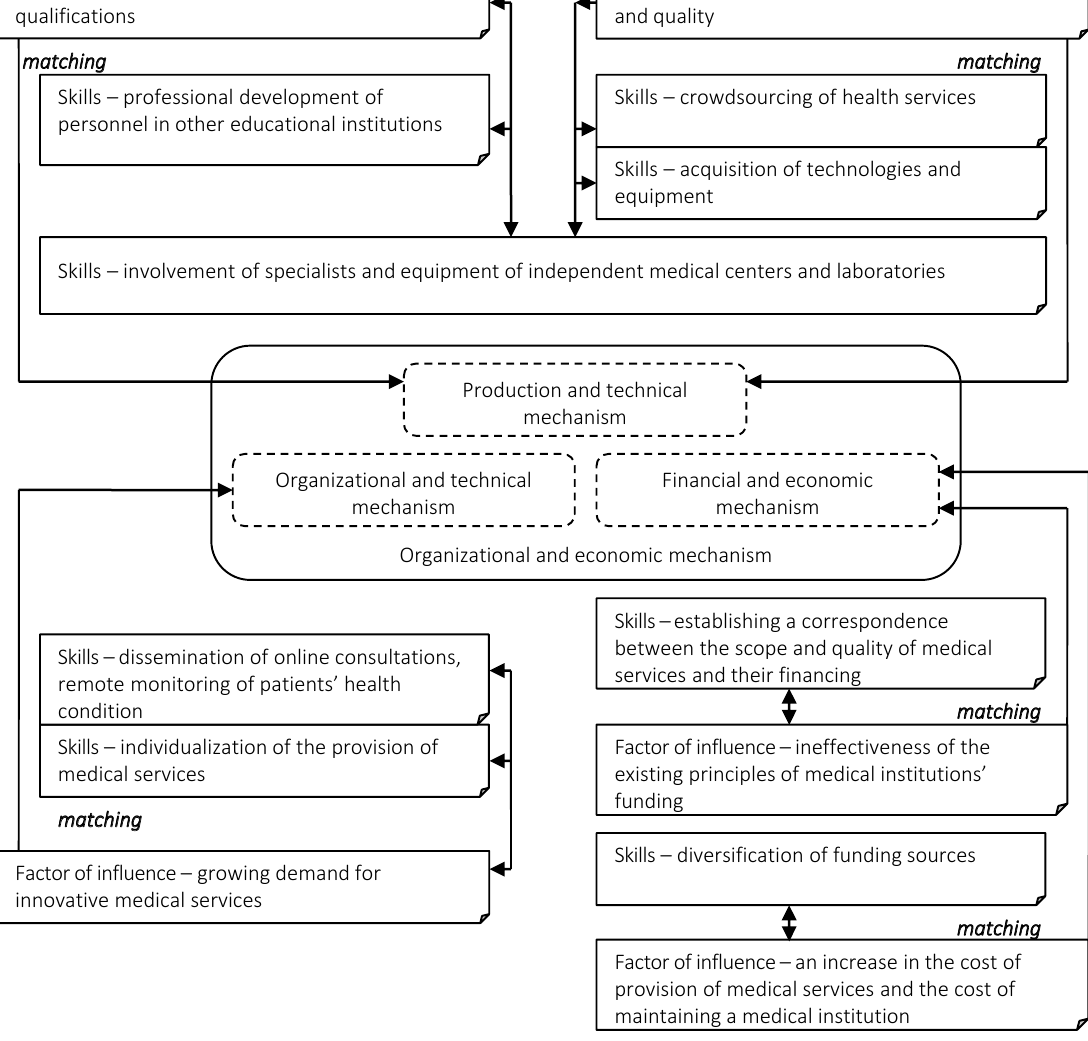
Figure 2. Areas of influence of the conceptual model of medical institutions’ management in the context of promoting Open Innovation on its organizational and economic